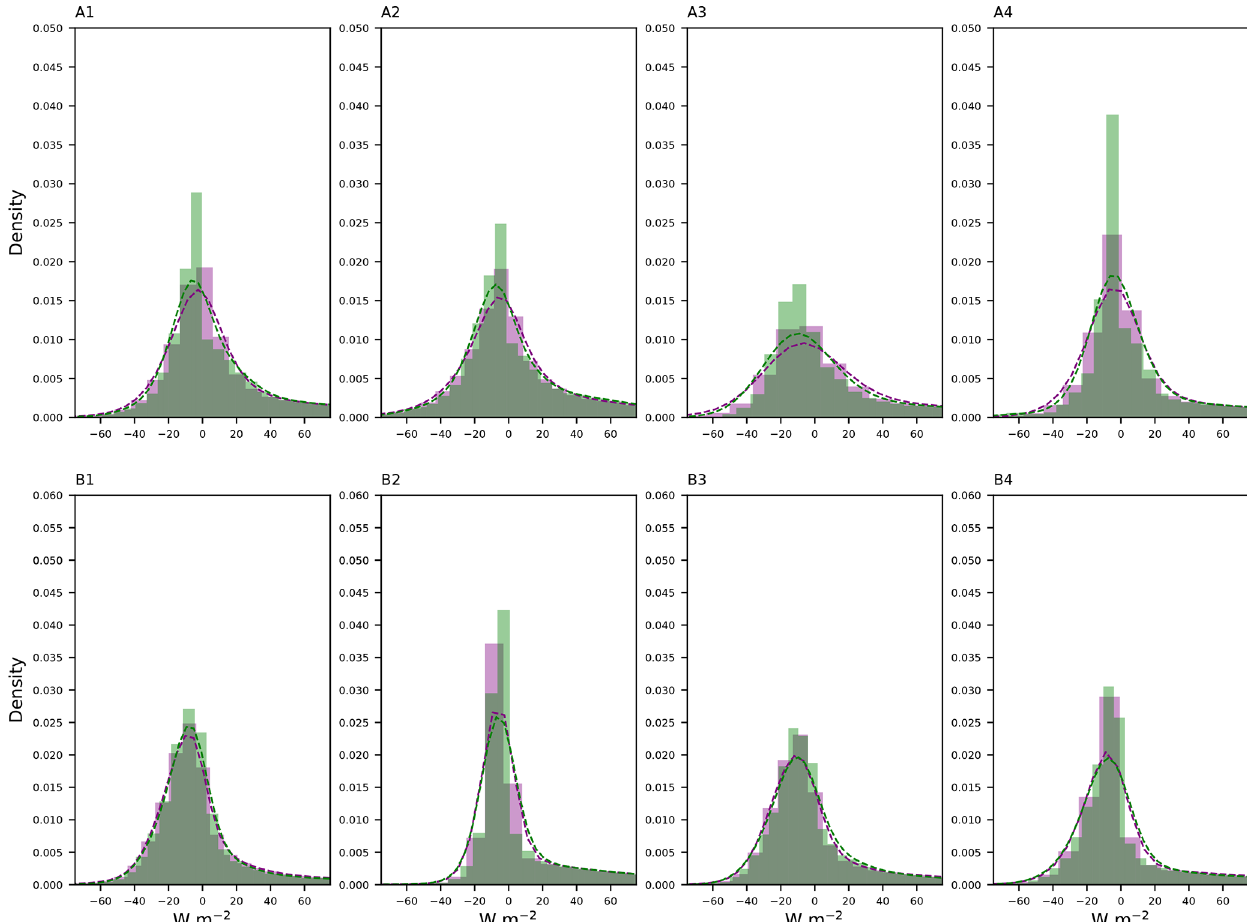
Figure 1. Histograms and Gaussian kernel density estimates (KDEs) (dashed line) for realistic (green) and sampled (purple) sensible heat fluxes at the PFT in the eight grid cells with 16 (top row) and 8 (bottom row) PFTs, respectively.